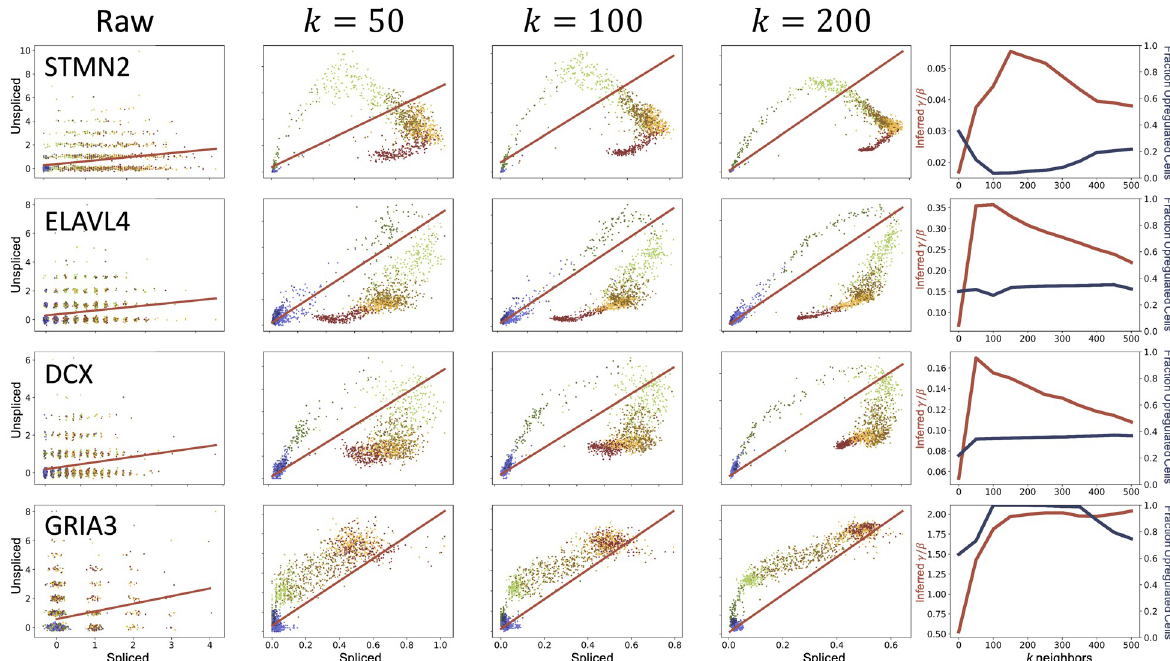
Fig 5. Distortions in data and instabilities in the inferred γ / β values introduced by the imputation procedure on the forebrain data from [1]. Column 1: Raw data (points: spliced and unspliced counts with added jitter; color: cell type, as in Fig 1; line: best fit line u = γ s / β + q , estimated from the entire dataset). Columns 2–4: Normalized and imputed data under various values of k (points: spliced and unspliced counts; color: cell type, as in Fig 1; line: best linear fit u = γ s / β + q , estimated from extreme quantiles). Column 5: Inferred values of γ / β (red, left axis) and inferred fraction of upregulated cells, defined as ∑ ( γ s / β + q ) > 0 (blue, right i u i − i